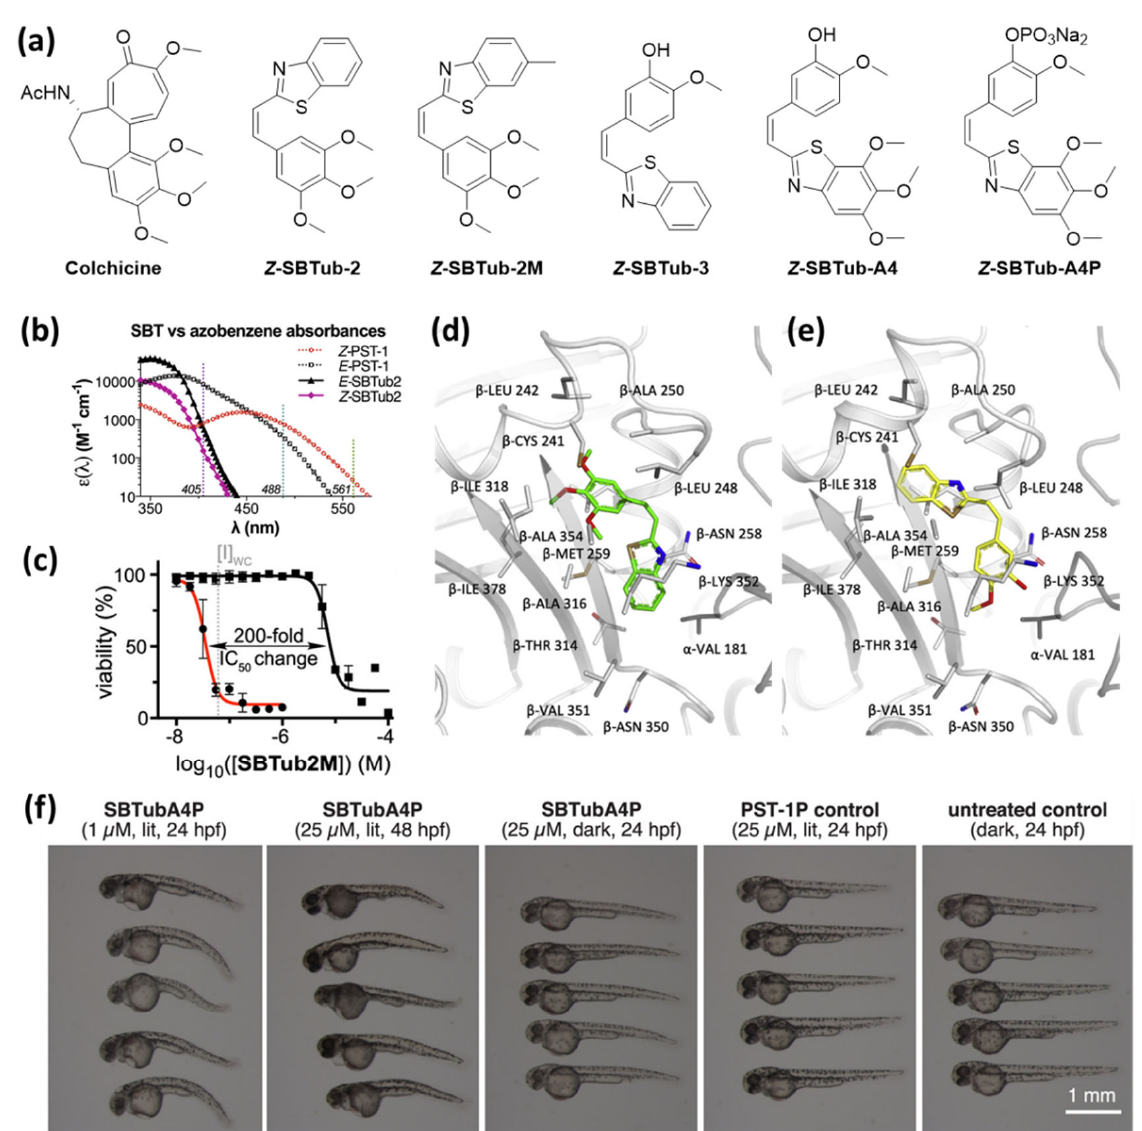
Figure 6. ( a ) Heterostilbenes with photoswitchable antimitotic activity. ( b ) Comparison of absorbance spectra of both photoisomers of SBTub2 and PST ‐ 1 ( azo ‐ CA ‐ 4 ) demonstrates orthogonality to the common laser wavelengths above 410 nm applied for imaging. ( c ) The results of light ‐ dependent viability assays with SBTub2M show highly nonlinear dose–response profiles with a high lit/dark ratio of bioactivity. ( d , e ) X ‐ ray crystal structure analysis of the complexes ( d ) tubulin ‐ Z ‐ SBTub2 (PDB:6ZWC) and ( e ) tubulin ‐ Z ‐ SBTub3 (PDB: 6ZWB) revealed that both compounds bind to the colchicine site. ( f ) SBTubA4P (1 or 25 μ M) causes morphological abnormalities in the development of D. rerio selectively in the lit state. [28,45] ( C , F ): Reprinted from the ref. [45] ; ( B , D , E ): Reprinted with permission from the ref. [24,28] . Copyright (2021) Elsevier.